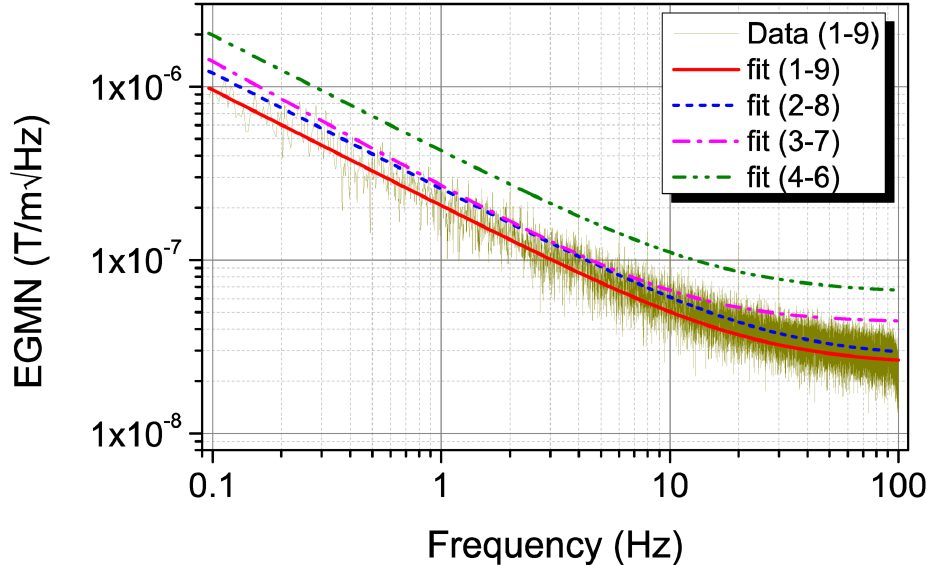
Figure 3. Frequency– dependence of EGMN of 4 voltage pairs 1–9, 2–8, 3–7 and 4–6. Data and fit according to Equation (8) are shown only for the 1-9 voltage pairs. For clarity, only the fit is shown for remaining